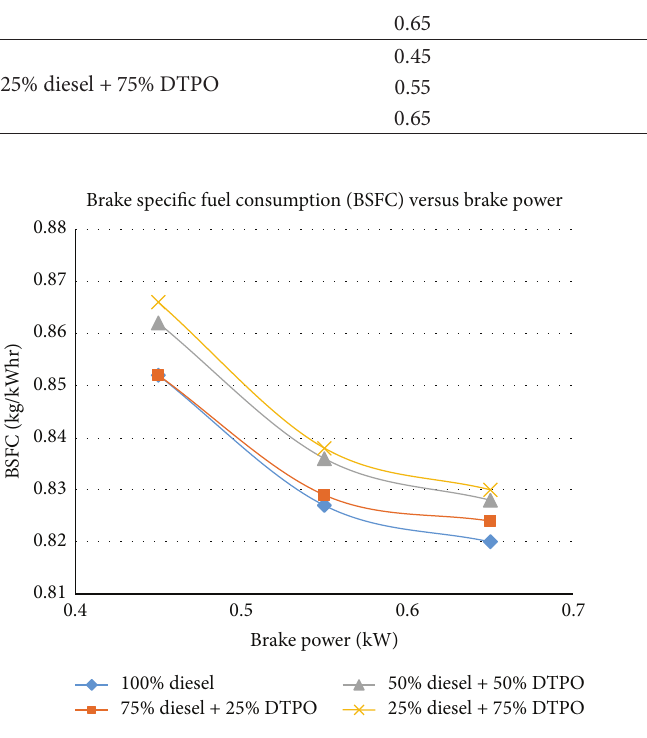
Figure 9: Variation of BSFC with respect to brake power at 27% part load.